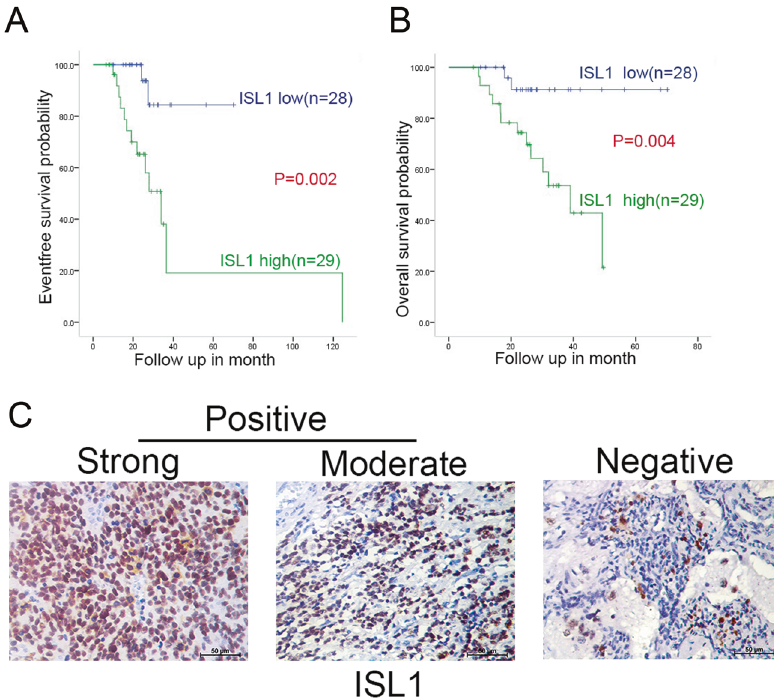
Fig. 3 Association of ISL1 expression with the EFS and OS in clinical NB patients. A , B Kaplan-Meier survival curves about EFS and OS in 57 NB patients expressing different ISL1 levels (*** P < 0.001). C Typical pictures of IHC analysis in NB tissues with various expression levels of ISL1 (scale bar, 1.0